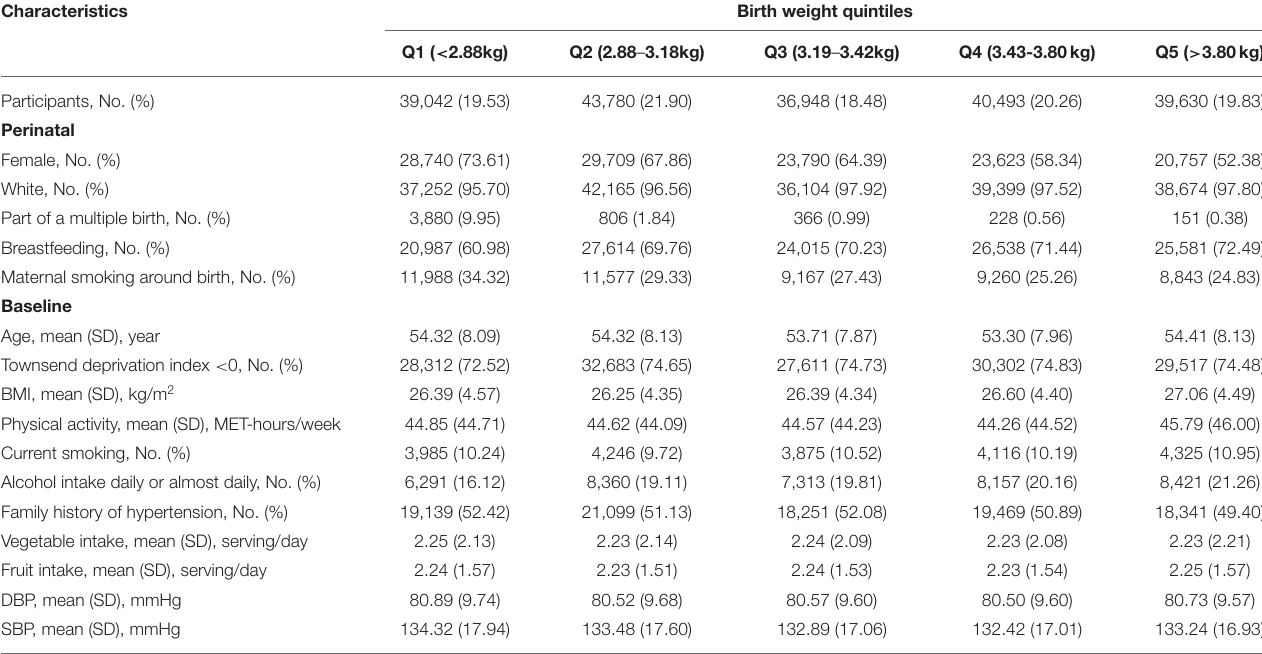
TABLE 1 | Basic characteristics of study participants according to birth weight. Characteristics